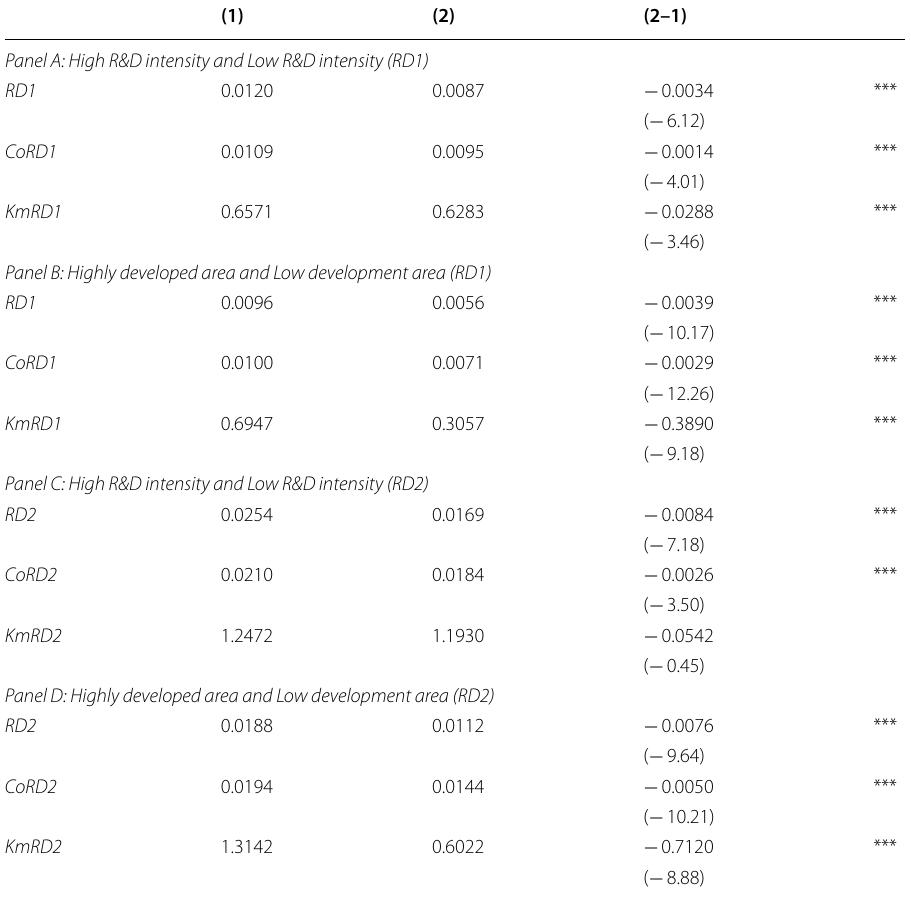
Table 3 Characteristics of R&D intensity and development area